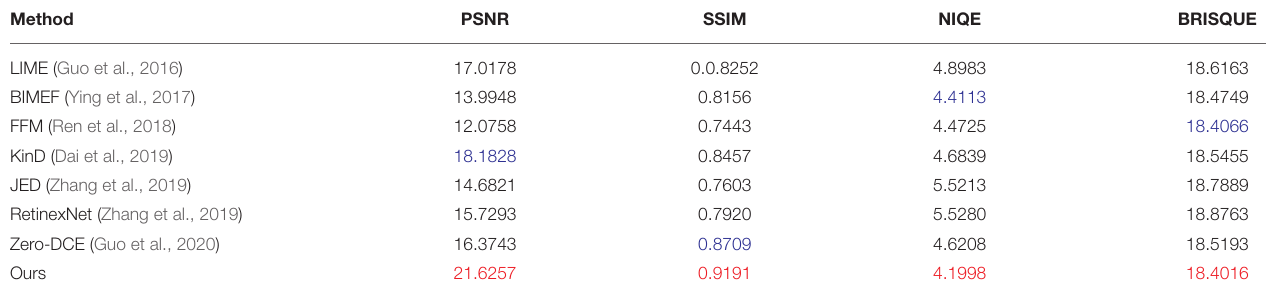
TABLE 1 | The average performance of the various enhancement methods in Figure 7 , with the best results labeled in red and the second-best results in color.